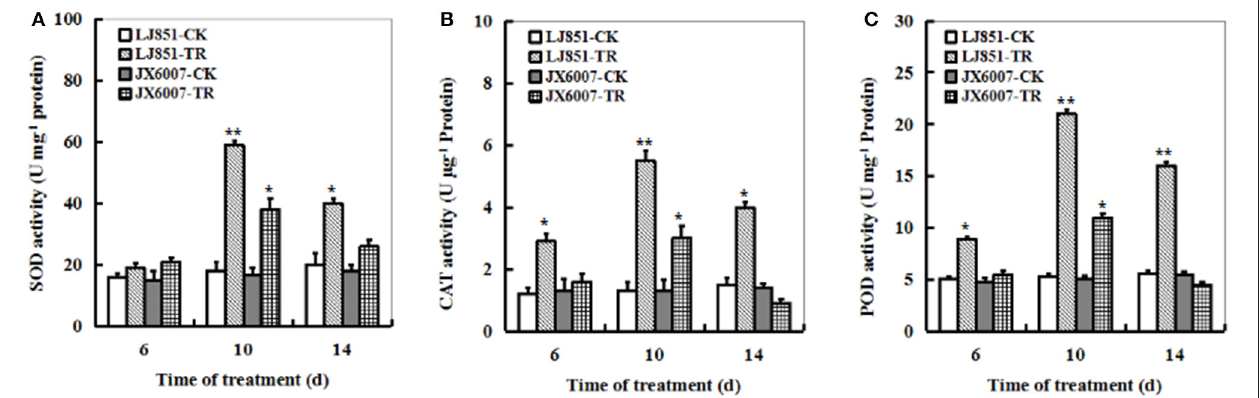
FIGURE 3 | Dynamic changes of SOD (A), CAT (B) , and POD (C) activities in both types of tobacco plants during 14 days of drought stress. LJ851-CK stands for LJ851 under control conditions; LJ851-TR stands for LJ851 under drought conditions; JX6007-CK stands for JX6007 under control conditions; JX6007-TR stands for JX6007 under drought conditions. Bar indicates SE. * t -test, with P < 0.05; ** t -test, with P < 0.01.